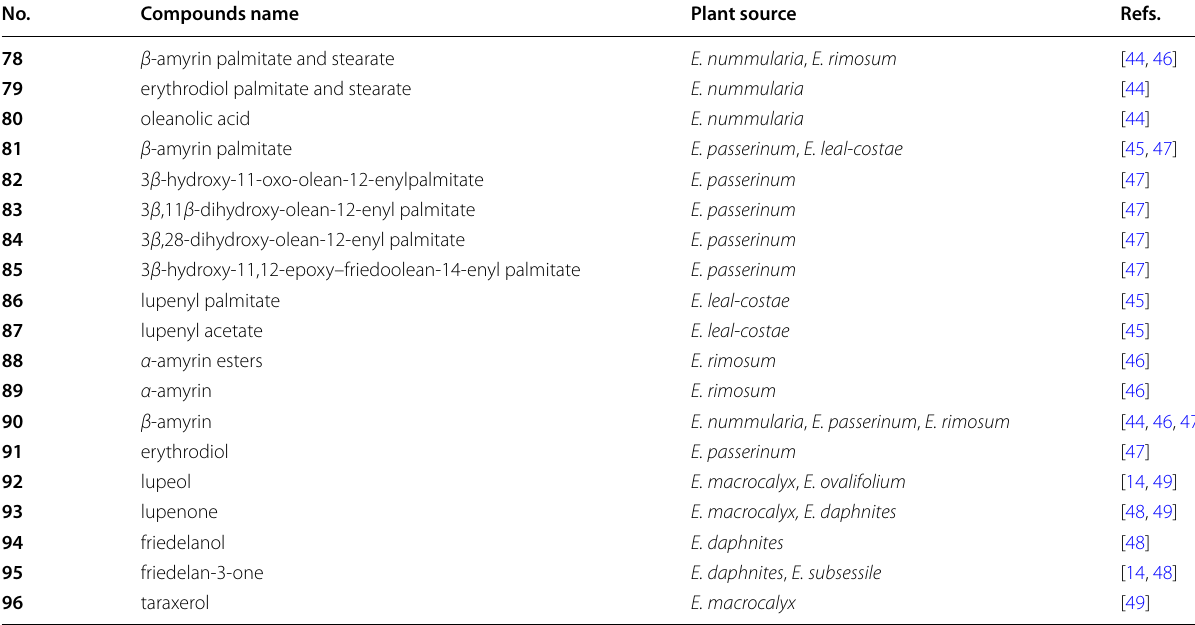
Table 5 Triterpenoids isolated from Erythroxylum plants